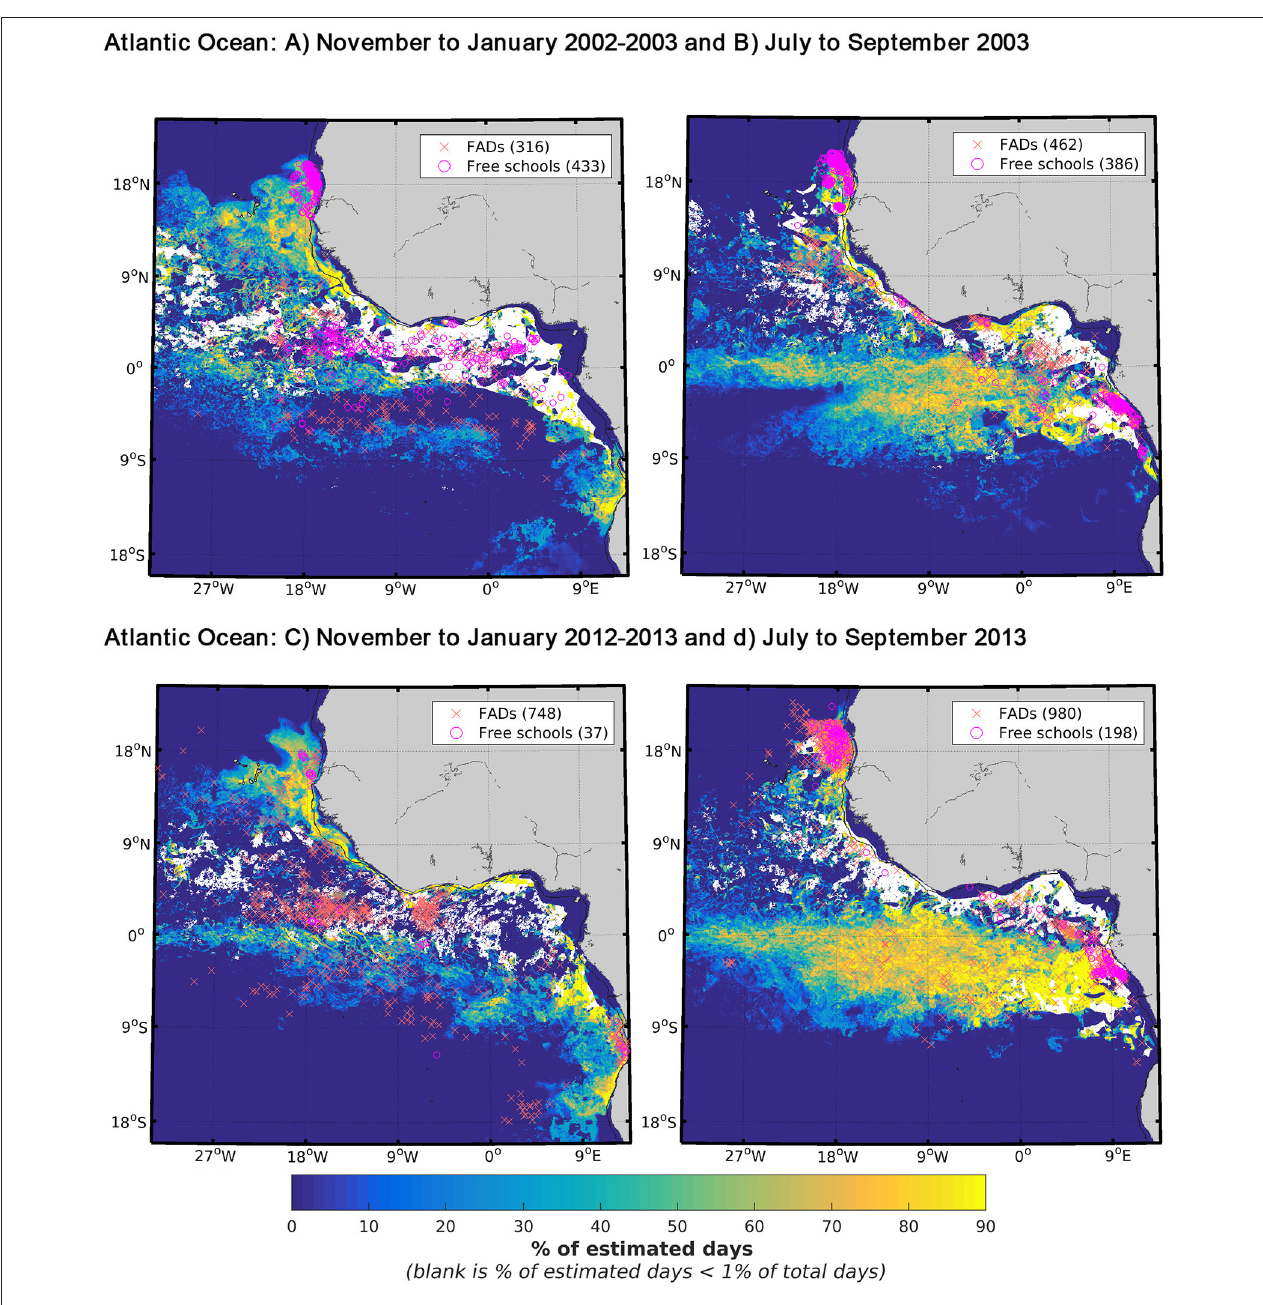
IO ( Figure 6B ). From 1998 to 2003–2004, habitat size increased 38% while catch rates increased 56%, However, from 2003